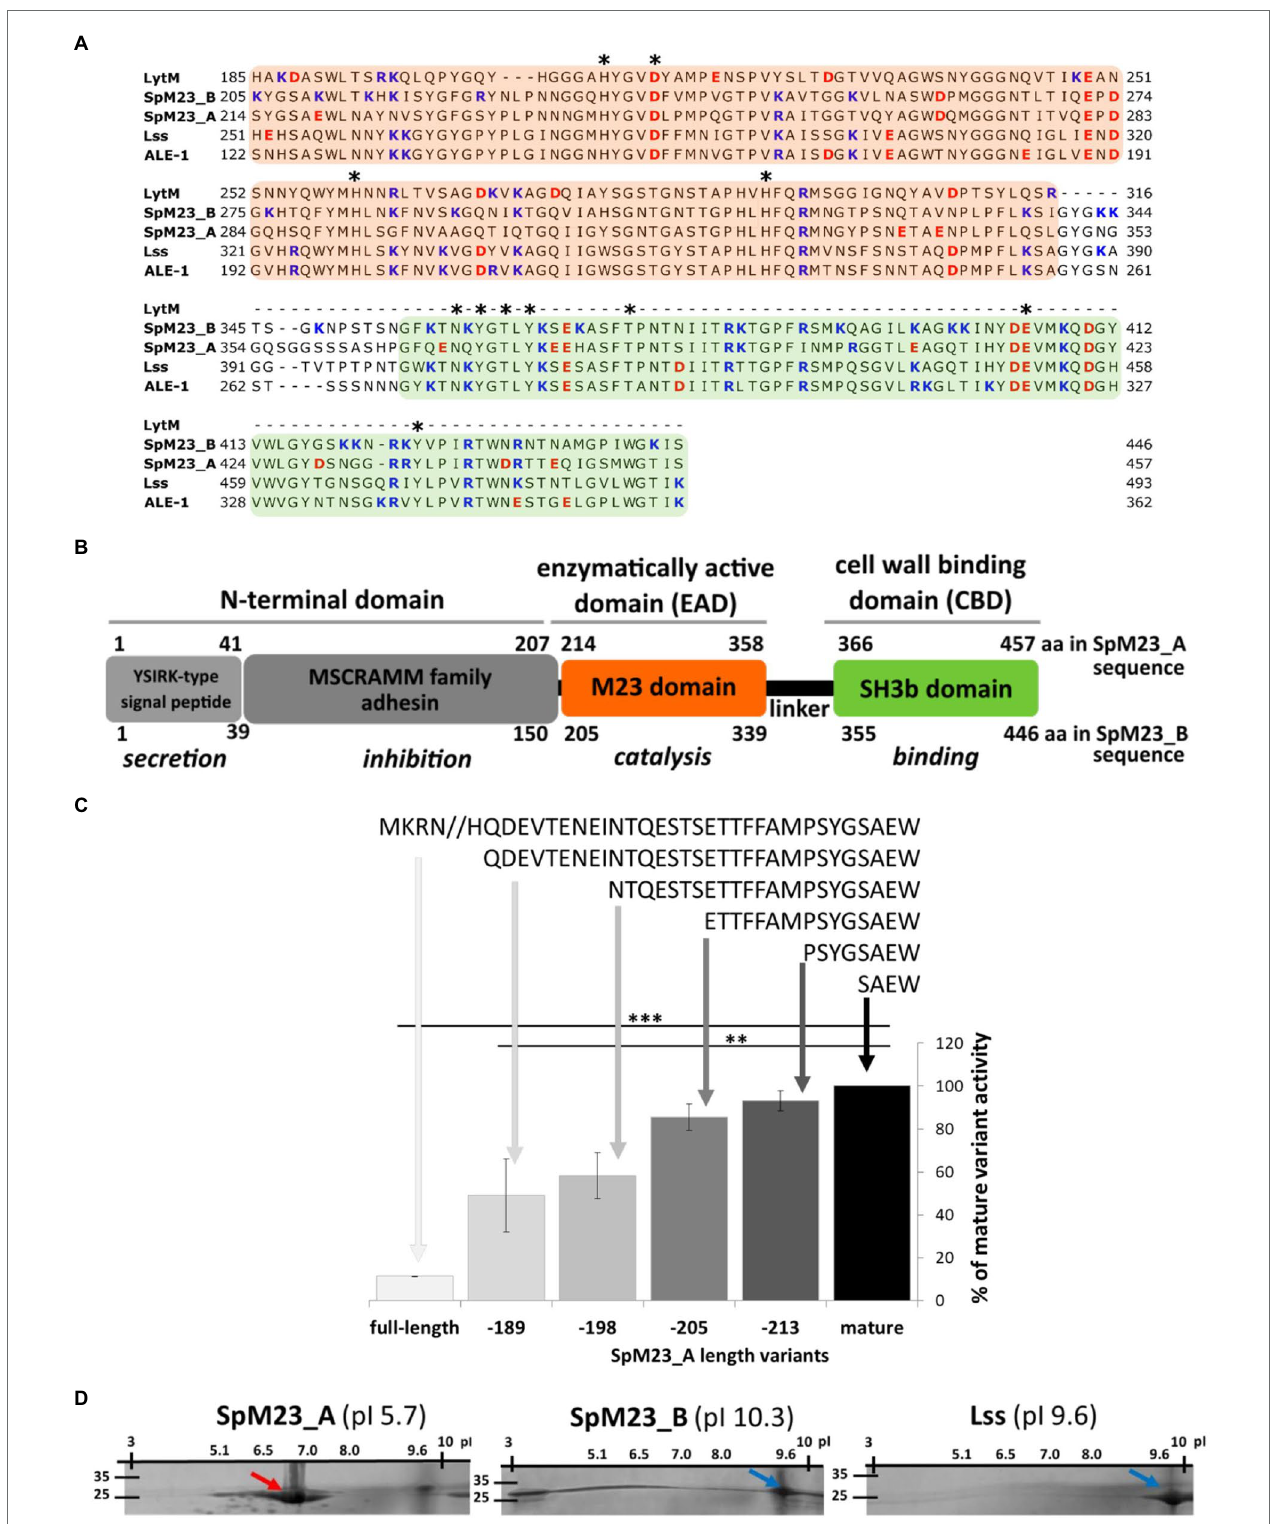
FIGURE 1 | Modular architecture and charge analysis of the novel M23 peptidases. (A) Sequence alignment of the selected enzymes with the M23 catalytic and SH3b binding domains in CLUSTAL Omega (Madeira et al., 2019). Domain sequences are indicated against a background colored according to the color scheme in (B)